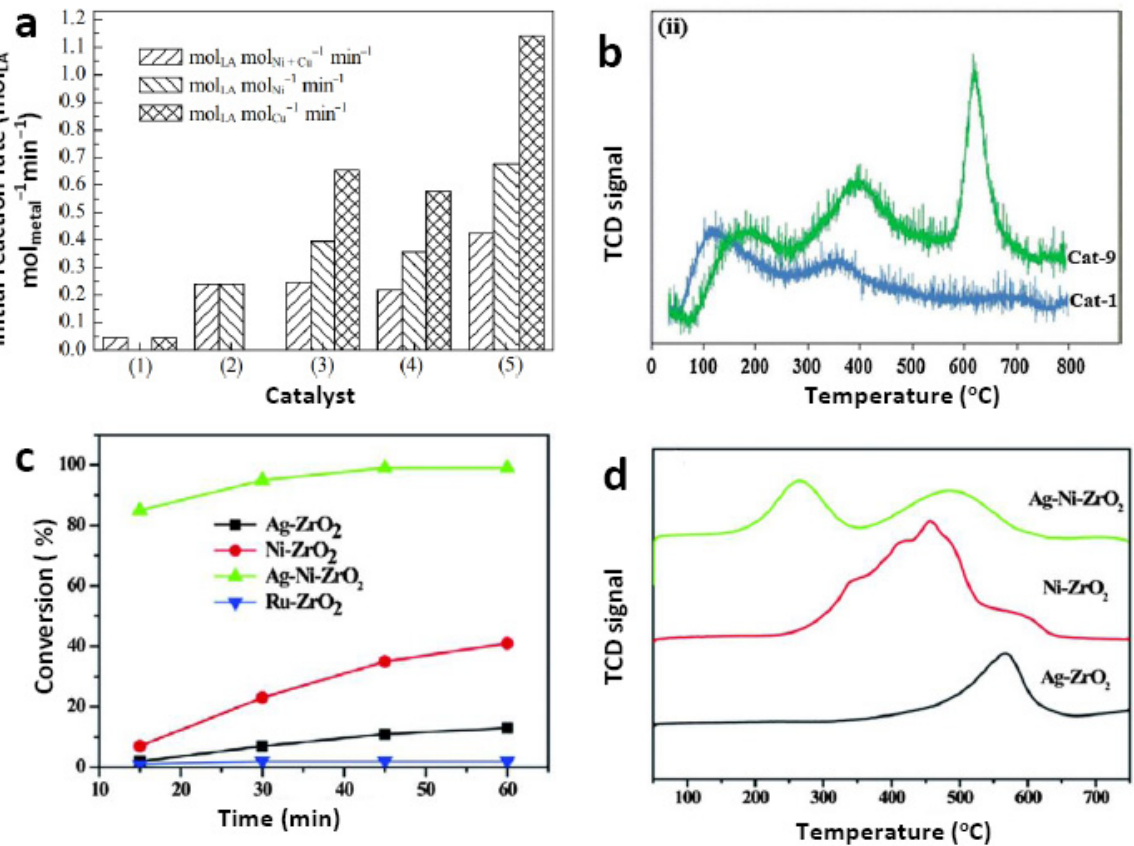
Figure 4. ( a ) Metal ‐ normalized reaction rates over catalysts of (1) Cu/Al 2 O 3 (WI), (2) Ni/Al 2 O 3 (WI), (3) Ni–Cu/Al 2 O 3 (WI), (4) Ni–Cu/Al 2 O 3 (SG 300) and (5) Ni–Cu/Al 2 O 3 (SG 450). Reproduced with permission from Reference [59]. Copyright 2014, Elsevier Ltd. ( b ) CO 2 ‐ TPD profiles of Cat ‐ 9 (Cu/Ni/Mg/Al with 0.75/0.5/1/1 molar ratio) and Cat ‐ 1 (Cu/Al with 1/1 molar ratio). Reproduced with permission from Reference [20]. Copyright, 2018 Elsevier Ltd. ( c ) FA decomposition profiles for Ag/ZrO 2 , Ni/ZrO 2 , Ag–Ni/ZrO 2 and Ru/ZrO 2 . Reaction conditions: formic acid (43 mmol), water (90 mL), temperature (493 K), N 2 (1 atm) and catalyst (0.5 g). ( d ) H 2 ‐ TPR profiles of Ag/ZrO 2 ,